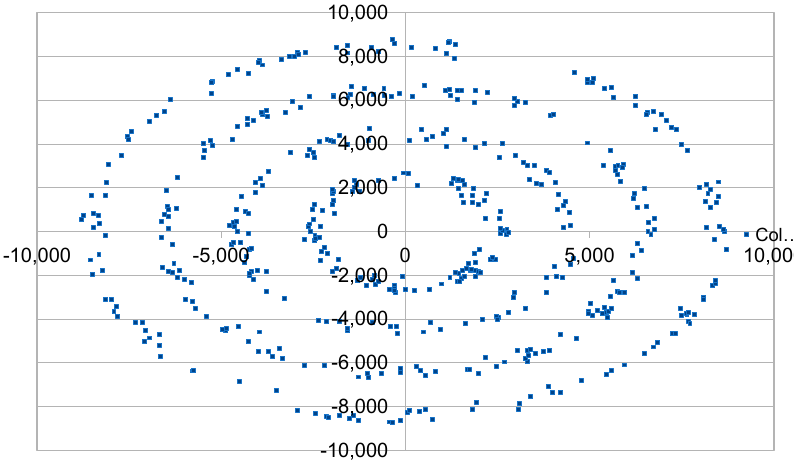
Figure 3. Simulation scenario with multiple rings end node spatial distribution.